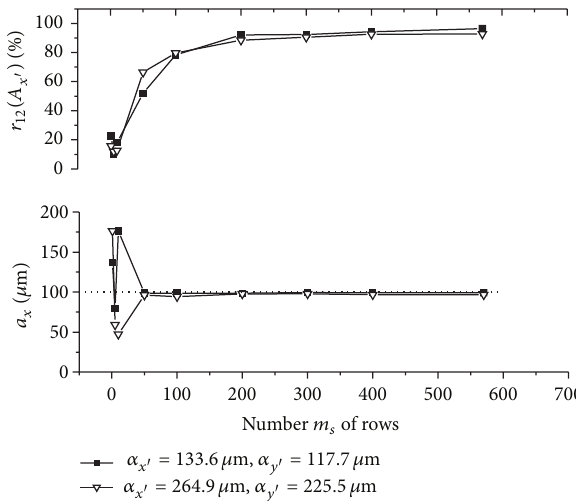
Figure 10: Resultant values of the evaluated object’s translation component 𝑎 𝑦 aswellasthemaximum 𝑟 12 (𝐴 𝑦 󸀠 ) ofthe1Dnormalized cross-correlation function 𝑟 12 of the intensity signals 𝐼 1 and 𝐼 2 as a function of number 𝑛 𝑠 of rows of the area used for the 2D intensity signal processing. The object is translated by 𝑎 𝑥 = 100 𝜇 m and = 0 𝜇 𝑎 𝑦